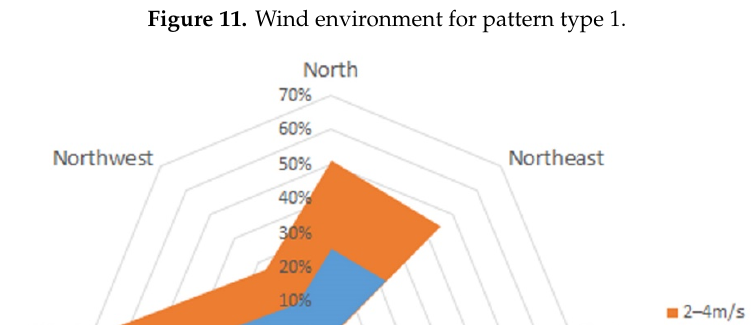
Figure 11. Wind environment for pattern type 1.